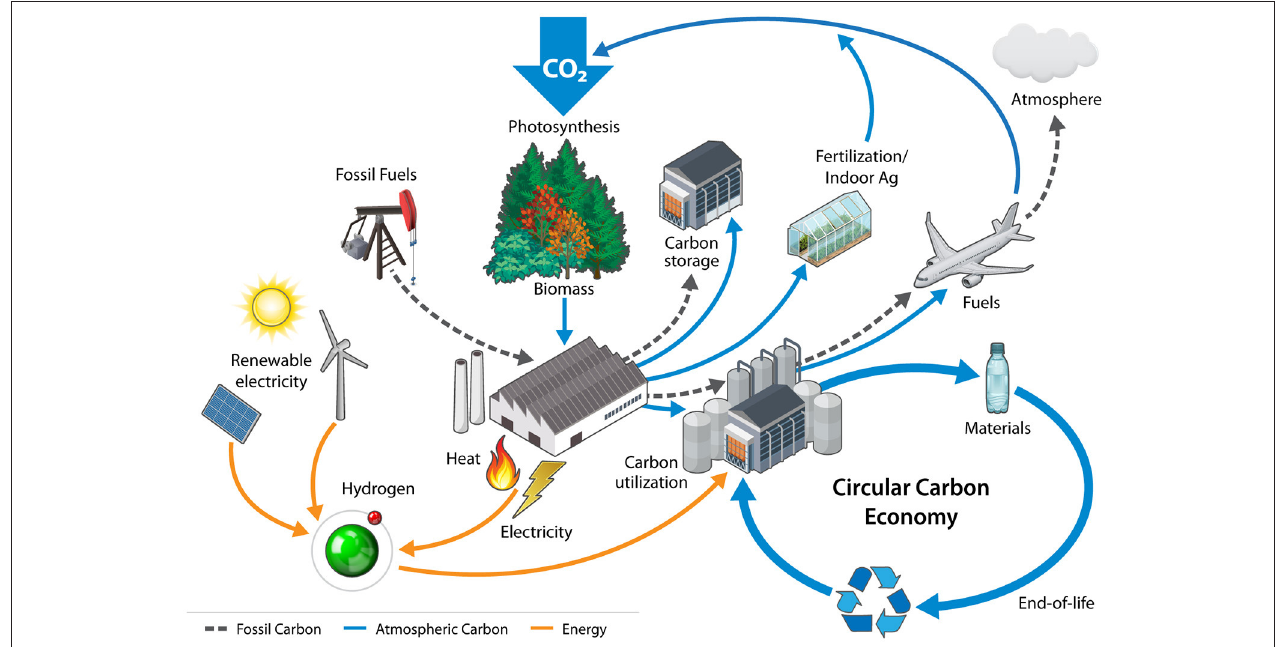
FIGURE 2 | The bio-based circular carbon economy can create an additional carbon sink in the technosphere via photosynthetic atmospheric carbon sequestration in biomass feedstock, energy, and material conversion pathways plus carbon capture and (re)utilization in closed circular carbon economy